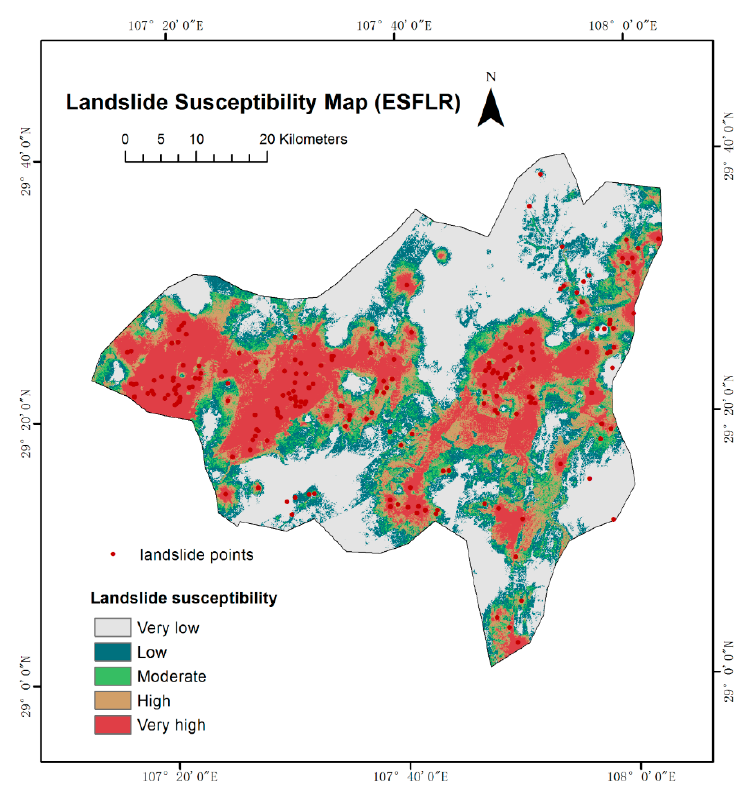
ISPRS Int. J. Geo-Inf. 2019 , 8 , x FOR PEER REVIEW Figure 7. Landslide susceptibility map for the ALR model. Figure 7. Landslide susceptibility map for the ALR model.